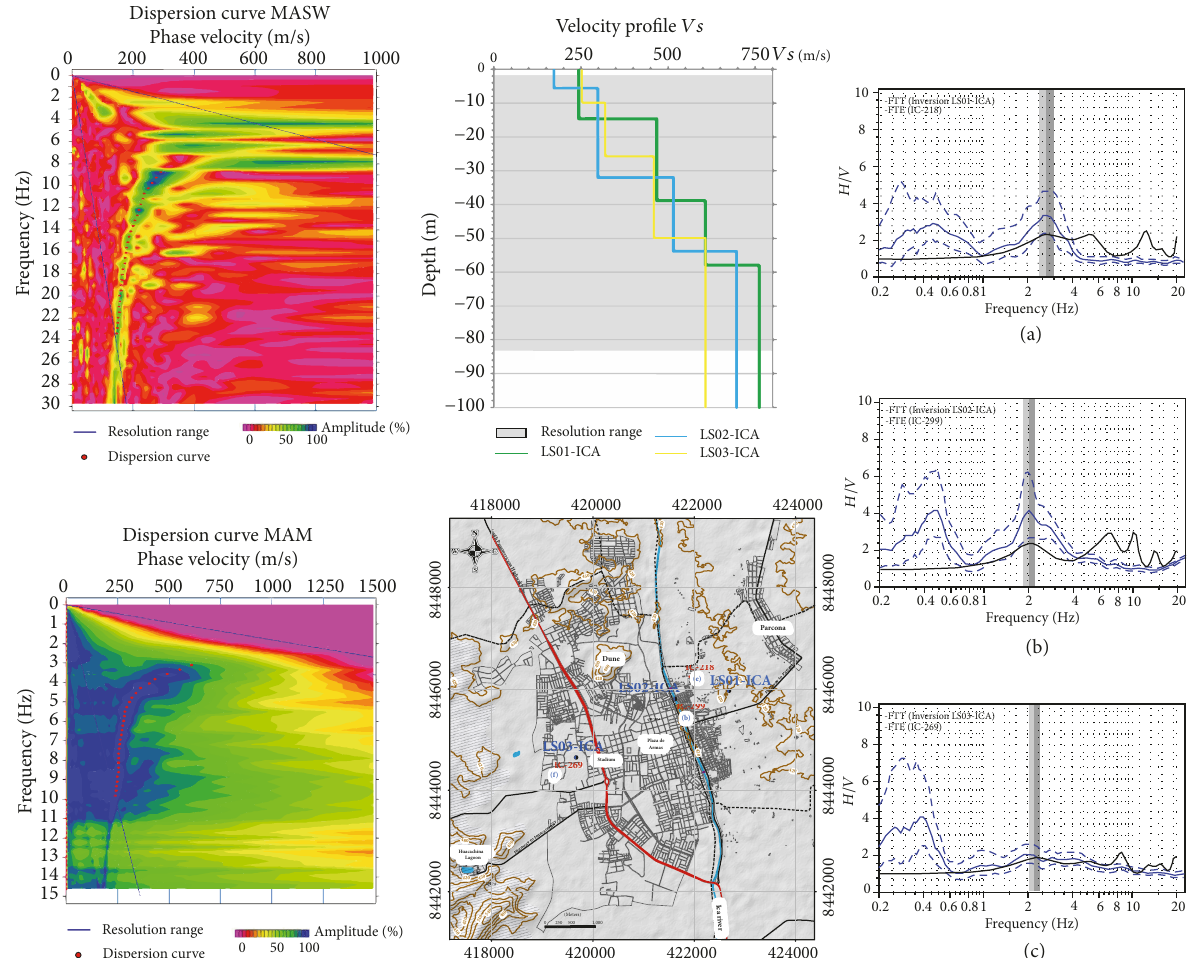
Figure 5: The left panels show the dispersion curves obtained with multichannel analysis of surface waves (MASW; top) and multichannel analysis of microtremors (MAM; bottom) methods. Here the averages and their inversions allow us to determine the velocity profile. The central plots show the velocity models (top) for the three linear arrays (bottom). The validation of the results is shown in the plots to the right. The inversion allowed us to obtain a theoretical transfer function (FTT; black line), which is superposed to the empirical transfer function (FTE; blue line) and shows a good correlation (degree of correspondence) with the fundamental frequency defined by the vertical gray